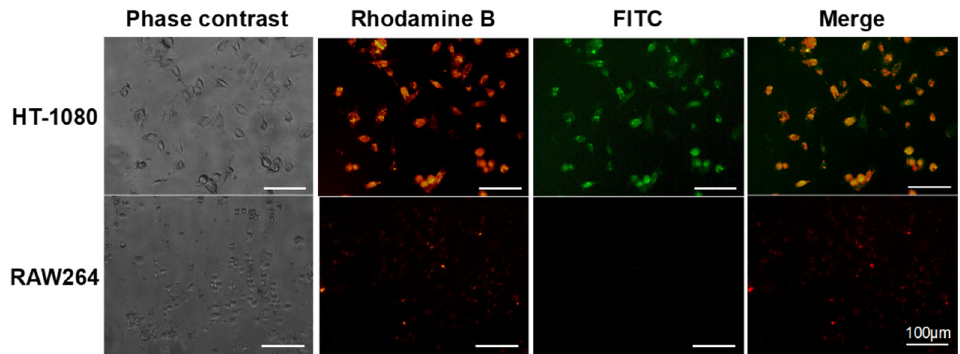
Figure 4. Phase contrast and fluorescence microscopic images of HT-1080 and RAW264 cells treated with the synthesized dendrimer.